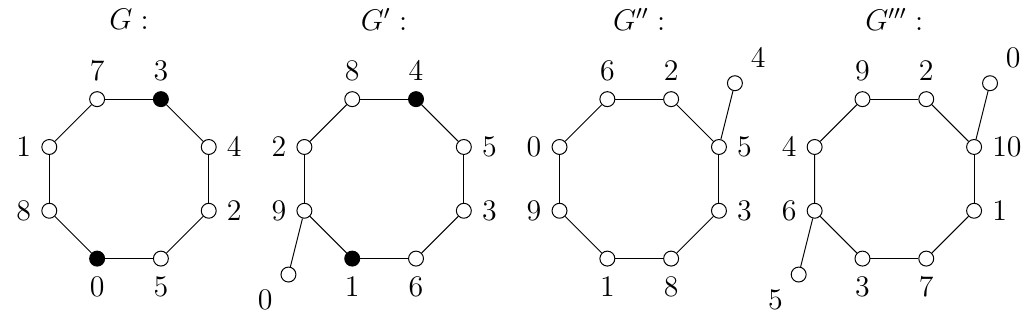
Figure 4: Creating compatible